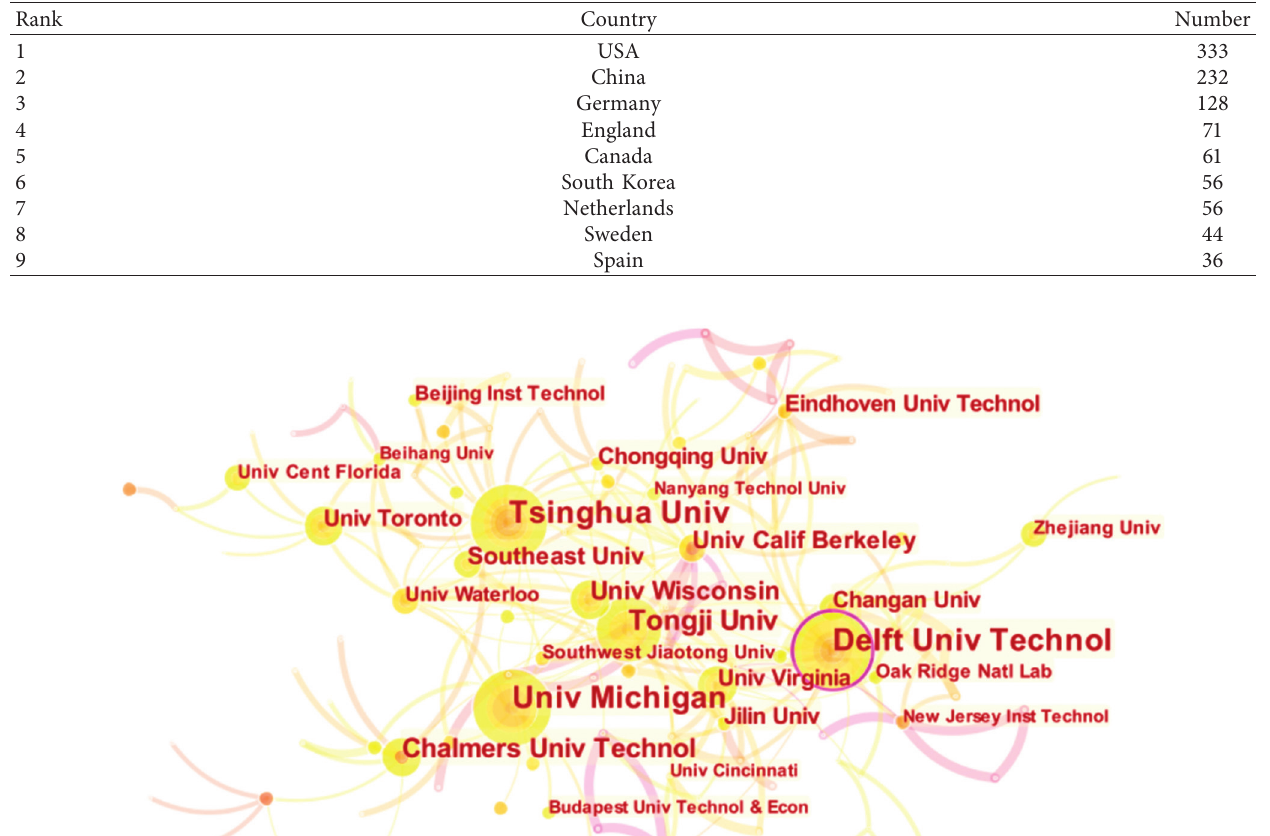
Table 2: The number of articles published by countries.